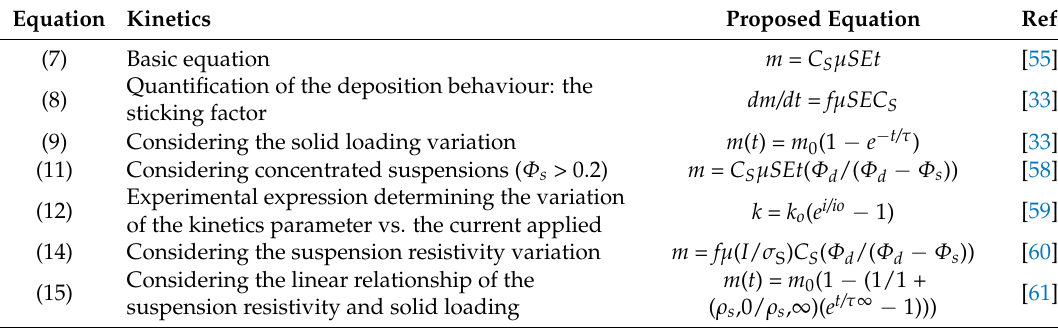
Table 1. Summaries of different equations, corrections and experimental expressions proposed by different